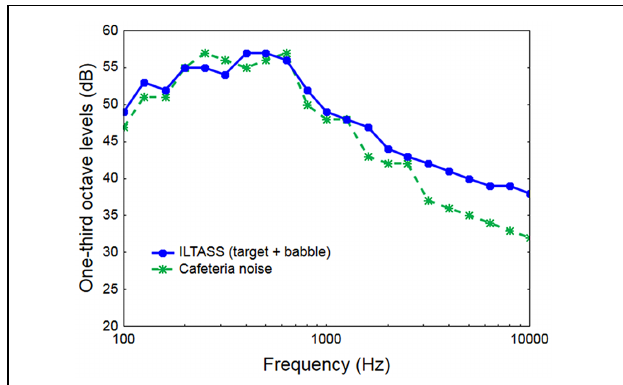
FIGURE 1 | The long-term spectra of the ILTASS (Byrne et al., 1994), that speech and babble-noise were filtered to match, and of the